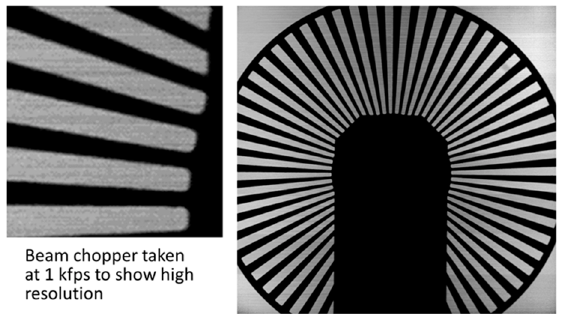
Figure 4. Evaluation of the spatial resolution: a laser beam chopper taken at 1 kfps. High resolution is achieved with 600 kpixels as an ultra-high-speed image sensor.